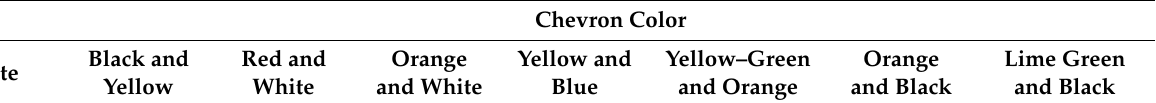
Table 10. TMA chevron color used by